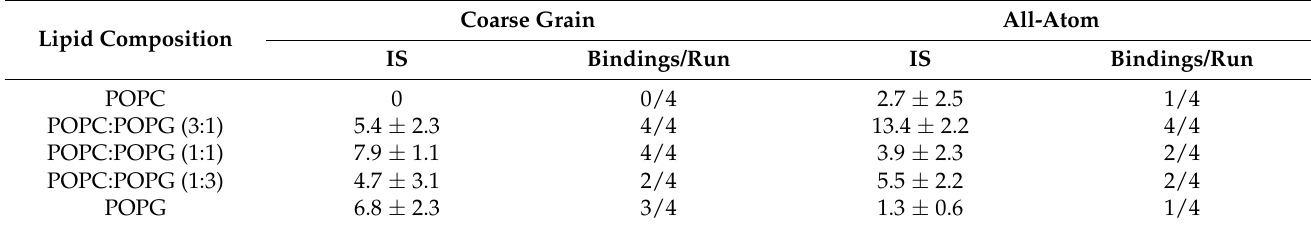
Table 1. Insertion Score (IS) of SNX-482 in lipid bilayers of different POPC/POPG ratio. Lipid